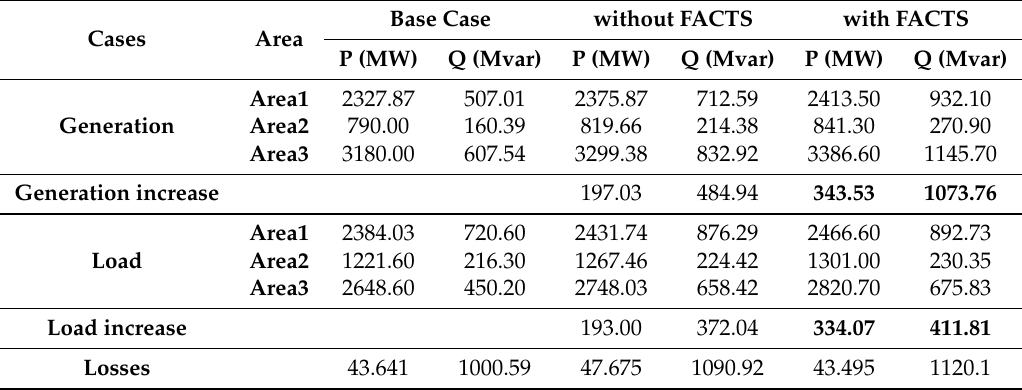
Table 7. Load and generation of IEEE 39 bus